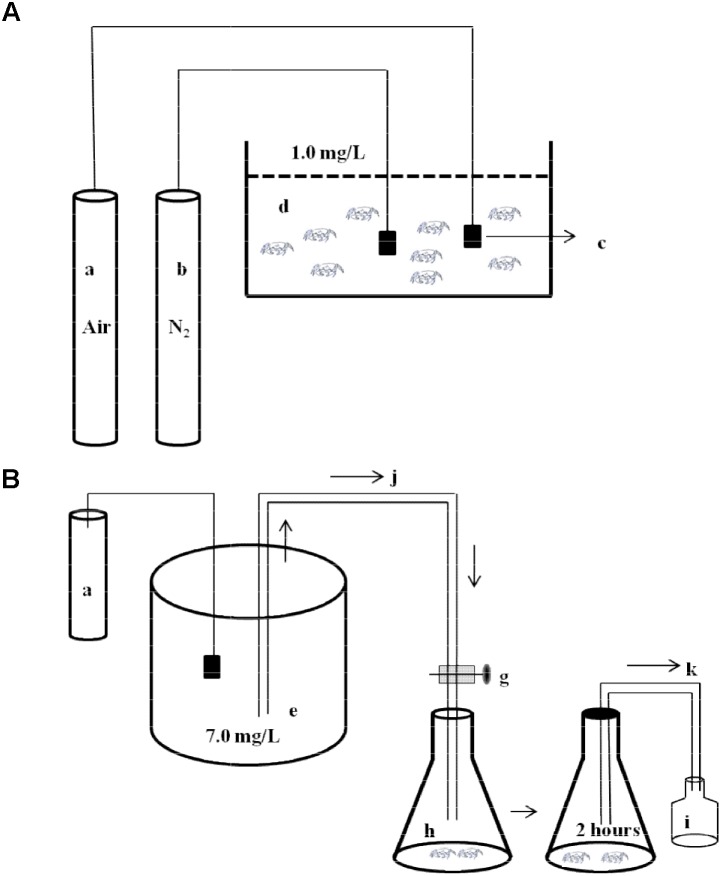
Schematic diagram of experimental design. (A) The diagram of environmental hypoxia stress to experimental animals. A part of stress animals were dissected to analyze activities of succinate dehydrogenase (SDH) and lactate dehydrogenase (LDH). Another part stress animals were transfer to the respiratory chambers to measure oxygen consumption rate (OCR) and ammonia excretion rate (AER). a, air pump; b, nitrogen container; c, air stone; d, hypoxia aquarium (DO 1.0 ± 0.2 mg⋅L-1). (B) The diagram of the respirometer. e, water reservoir (DO 7.0 ± 0.2 mg⋅L-1); g, valves; h, respiratory chamber; i, sample bottle; j, inflow; k, outflow. (OCR and AER measurement: water (DO 7.0 ± 0.2 mg⋅L-1) gently flowed into the respiratory chamber and then were sealed immediately using transparent plastic film. The experiment was carried out for 2 h. Initial and final DO and ammonia-nitrogen concentration were measured.).